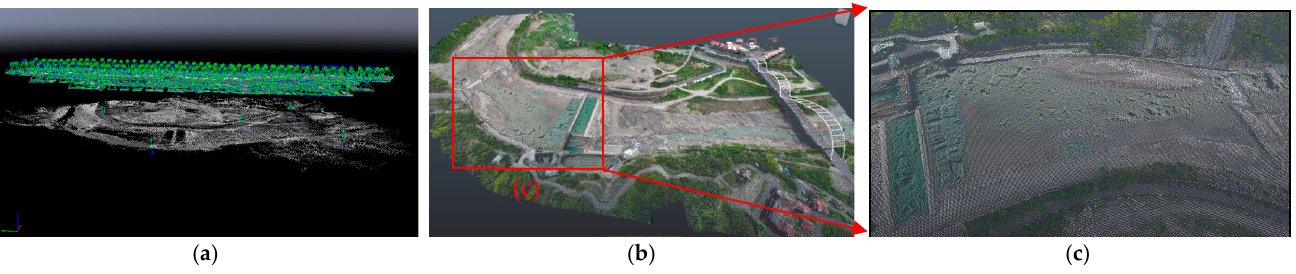
Figure 8. The picture of different bands taken by the Parrot Sequoia multispectral camera (2 May 2017) and mosaiced by pix4D software. ( a ) green band, ( b ) red band, ( c ) red edge band, and ( d ) NIR band.